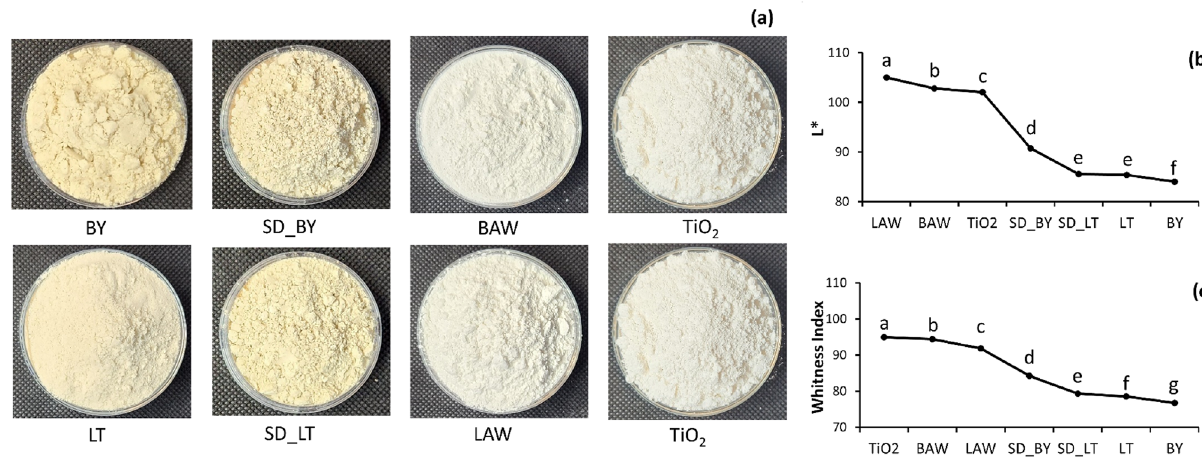
Figure 2. ( a ) millet flour and spray dried samples compared to TiO 2 ( b ) Lightness (L*) and ( c ) witnesses index values of the samples. Mean values followed by a different letter are significantly different. Legend: Image, L*, and whiteness index values of the flour and powder samples. BY: plain Barnyard millet flour; LT: plain Little millet flour; SD_BY: spray dried Barnyard millet soluble fraction; SD_LT: spray dried Little millet soluble fraction; BAW: 25% w/v Barnyard millet + acid whey; LAW: 25% w/v Little millet + acid